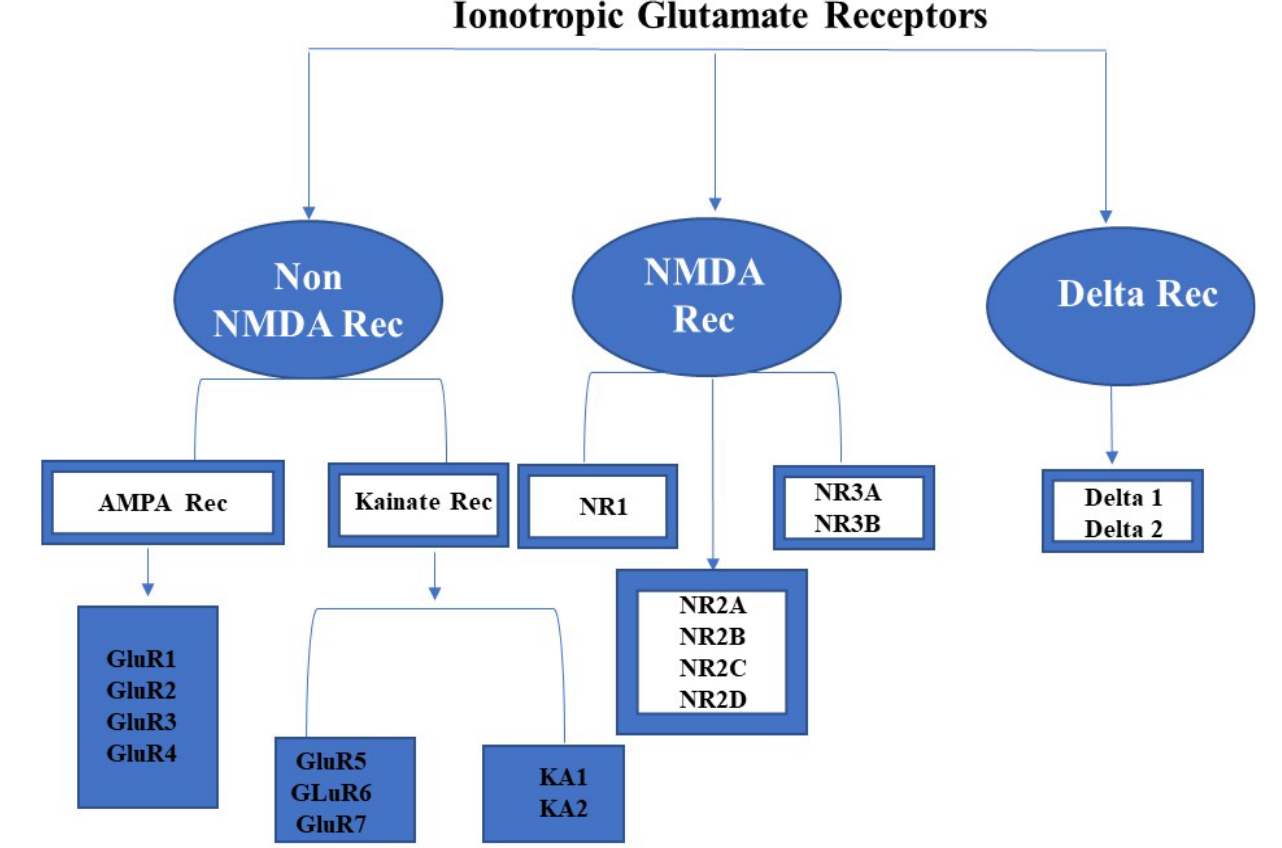
Figure 1. Different types of ionotropic glutamate receptors.